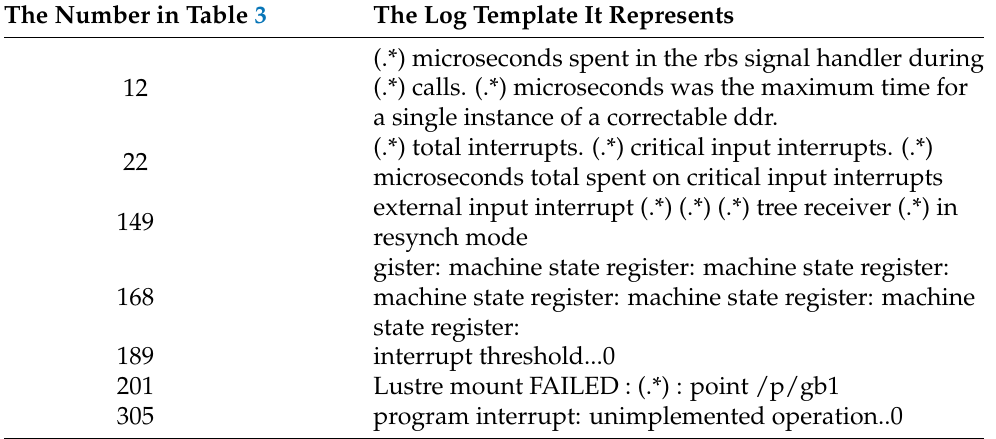
Table 4. Partially digitized BGL